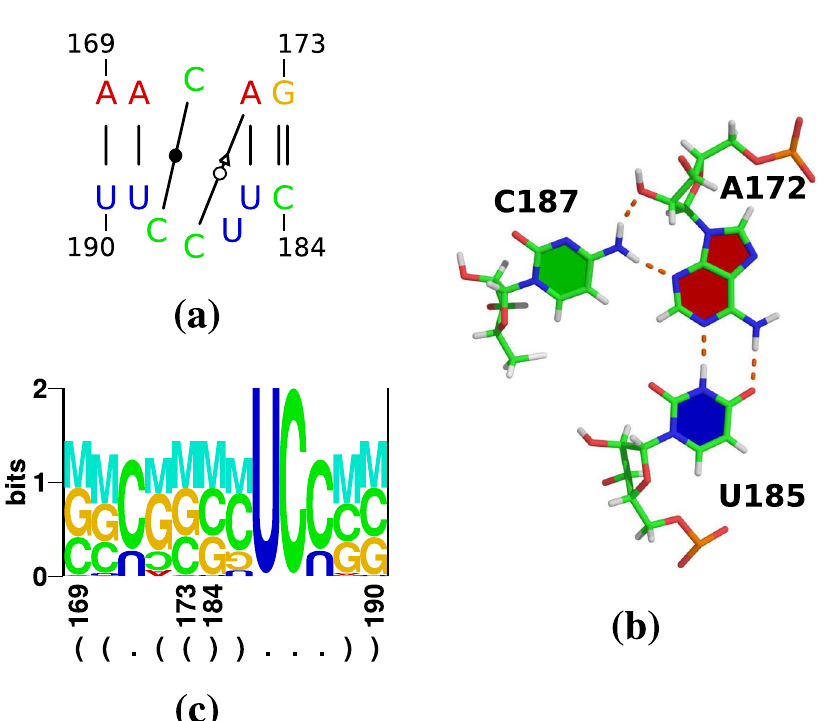
Figure 4. Results of Rosetta modelling of IL2 loop. ( a ) Interactions identified by rnaview in Rosetta’s top model. Loop nucleotides were highly connected by a complex network of base/base hydrogen bonds and stacking interactions. ( b ) Triple pair C 187 · A 172 :U 185 (cWW A 172 :U 185 , trans Watson/Sugar edge (tWS) C 187 · A 172 ). ( c ) Logo produced by RNAredesign for Rosetta’s top